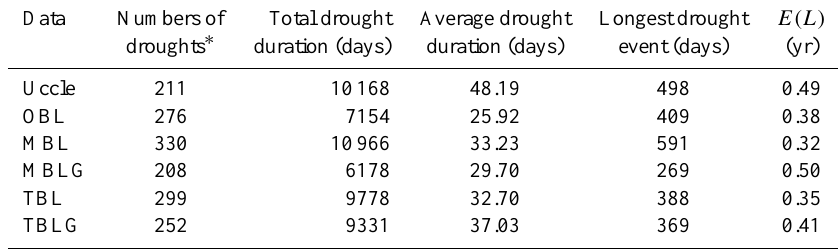
Table 5. Basic drought statistics of observed and simulated data.